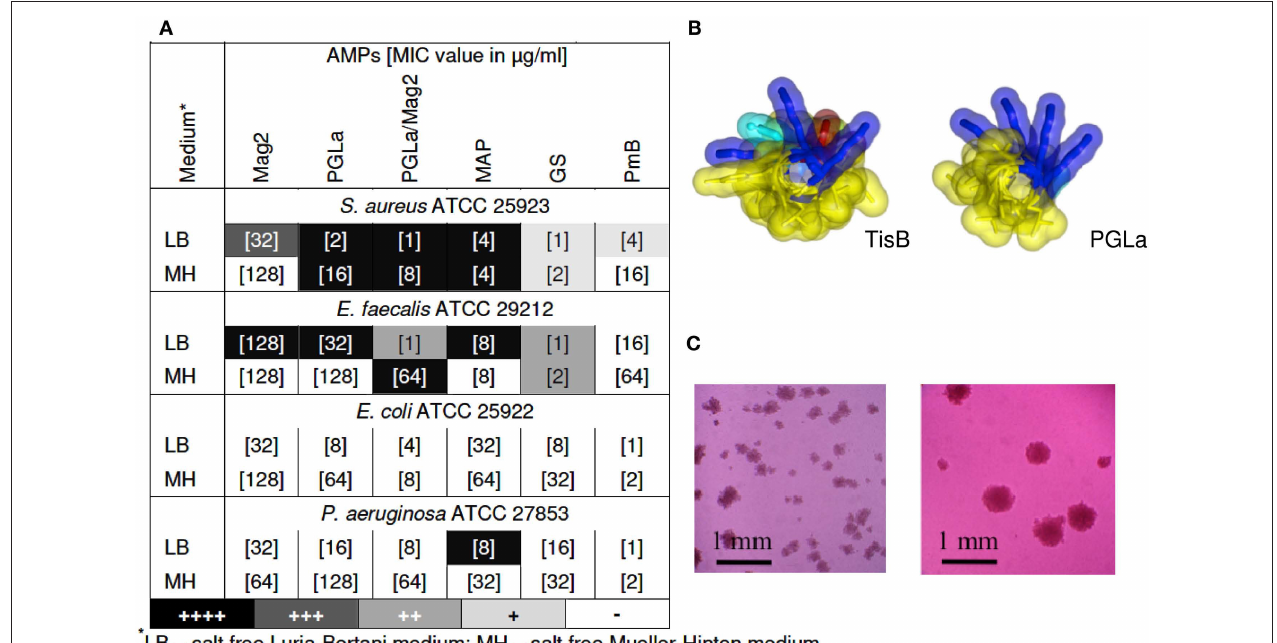
colonies was observed as an average of at least two independent experiments; (B) Molecular structures of TisB (left) and PGLa (right); (C) Pinpoint colonies of S. aureus in the presence of MAP were detected on the bottom of 96-wells microtiter plates with an inverted microscope (Leica DM IL) at 100-fold magnification – two individual microcultures under identical conditions are shown as